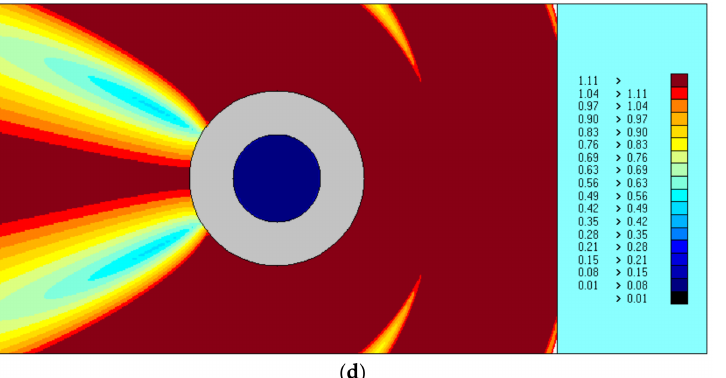
Figure 9. The wave amplitude distribution around the OWC for different ka . ( a ) ka = 0.4, ( b ) ka = 1.0, ( c ) ka = 1.5, ( d ) ka = 2.0.